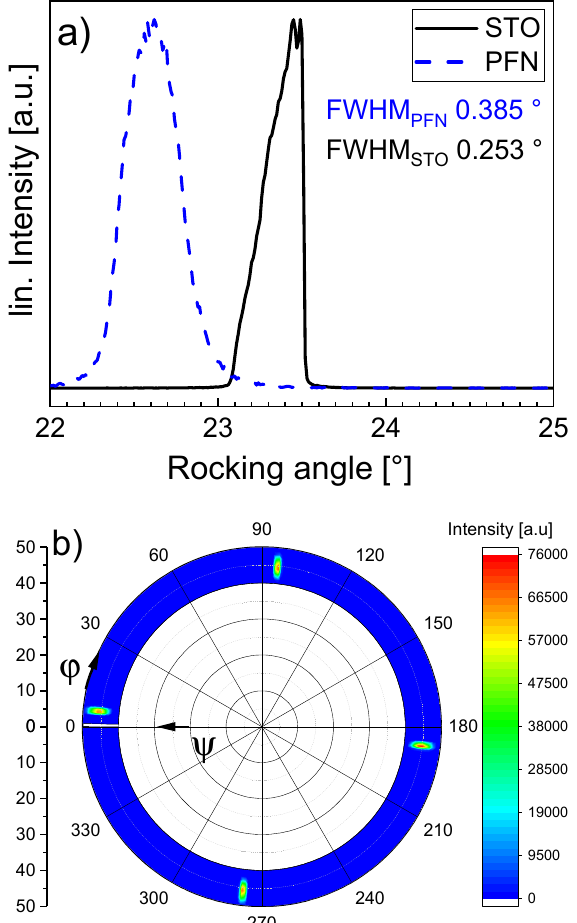
Figure 3. Rocking curve ( a ) and pole figure ( b ) measured for the PFN film deposited on an STO (001) substrate.